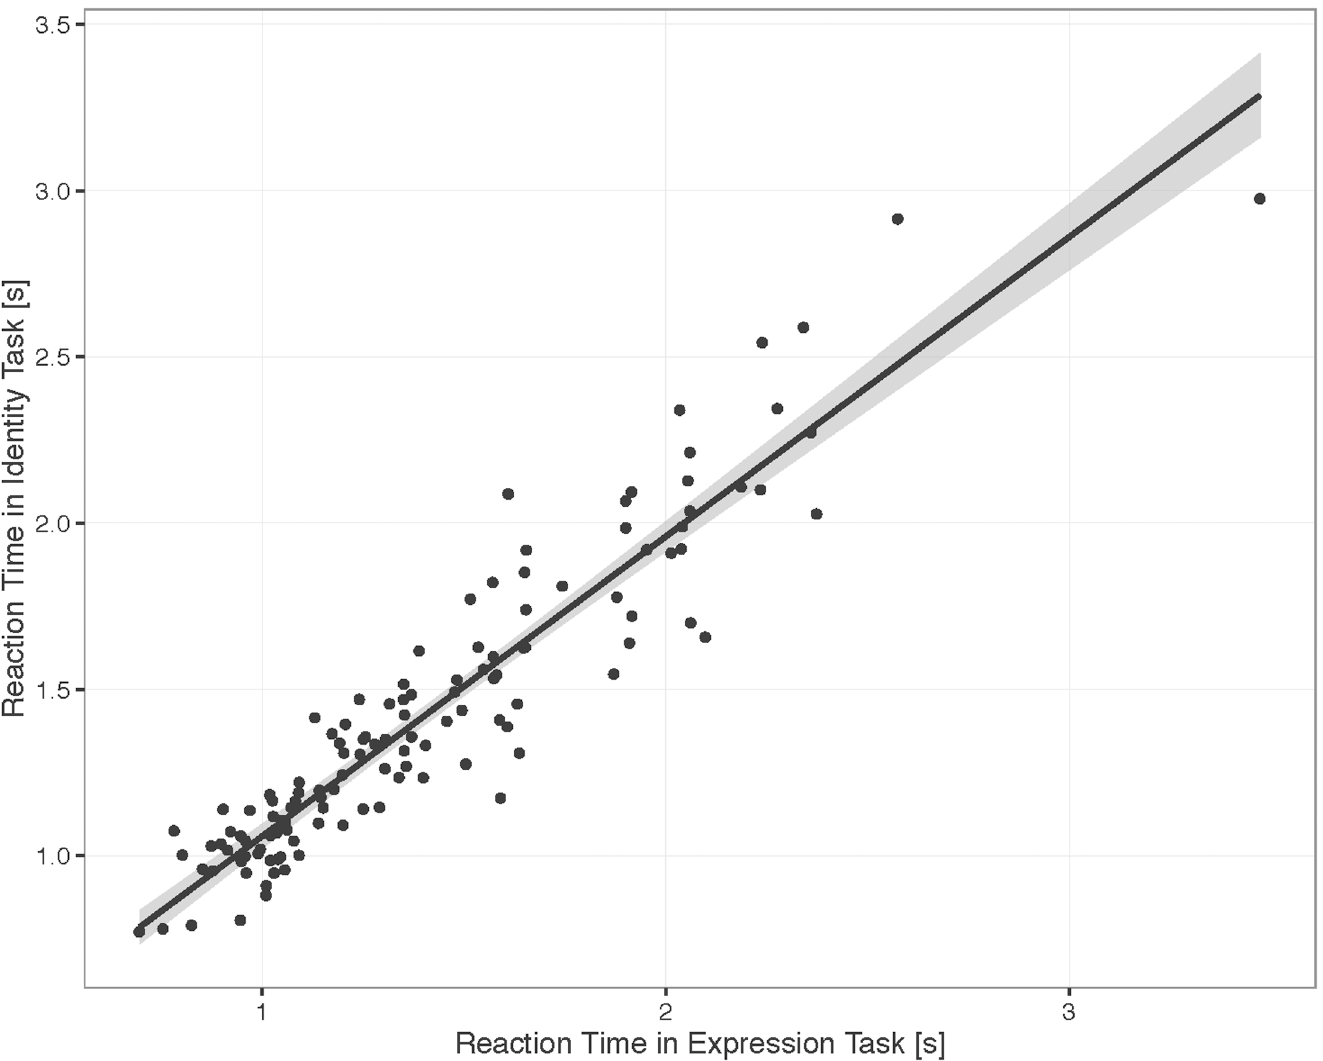
Fig 5. Correlation between identity and expression: Reaction time. Scatterplot illustratingcorrelation between participant reaction times on identity and expressiontasks (in seconds). Data includeonly trials that were answeredcorrectly (trials with 50% morphs are not includedbecausethey not have a correct response). Grey shadingindicates95%